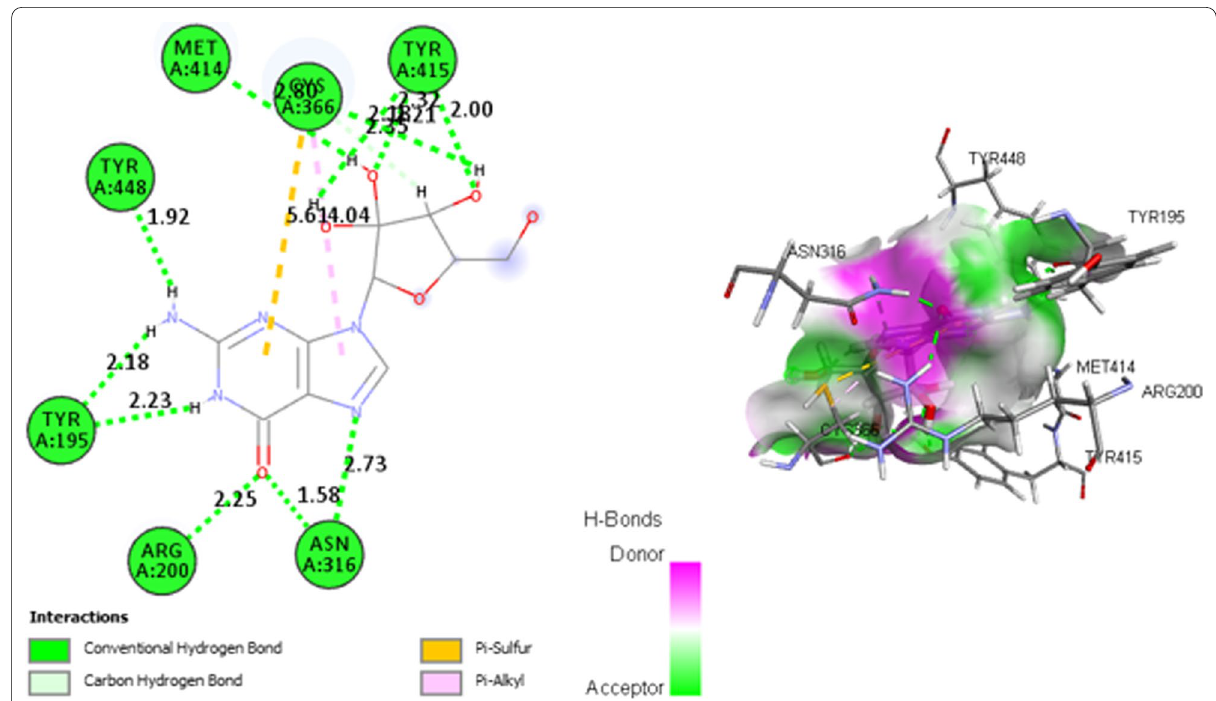
Fig. 4 2D and 3D view of the binding modes of design molecule ( 1c ) with HCV NS5B enzyme